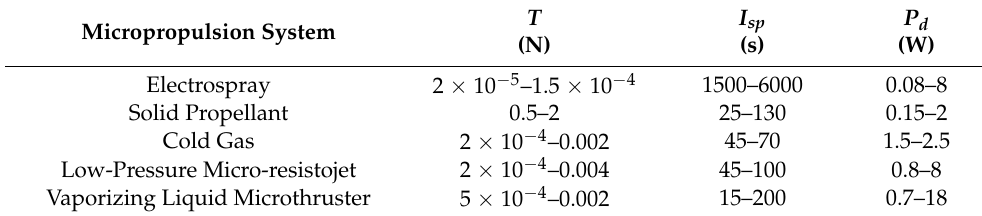
Table 1. Comparison of nominal power, thrust, and specific impulse between different types of micropropulsion systems